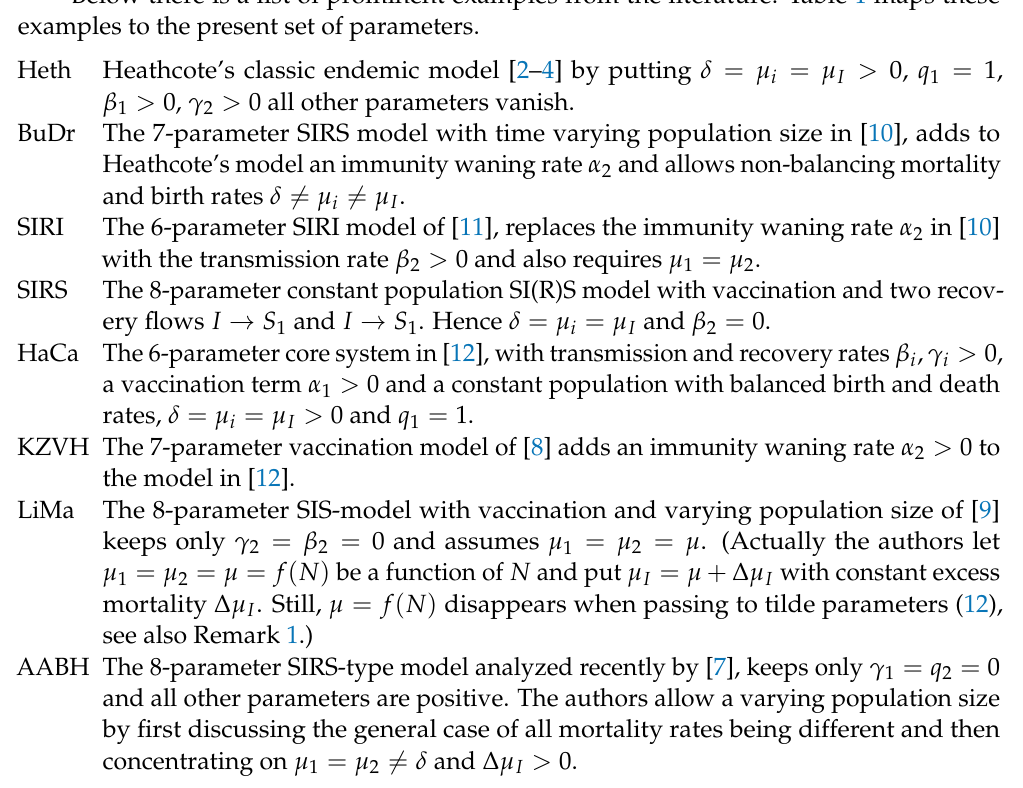
Table 1. Mapping models in the literature 1 to the present choice of parameters. The column # counts the number of free parameters in the original models. Passing to fractional variables ( S 1 , S 2 , I ) and tilde parameters, Equation (12), # eff counts the number of effectively independent parameters